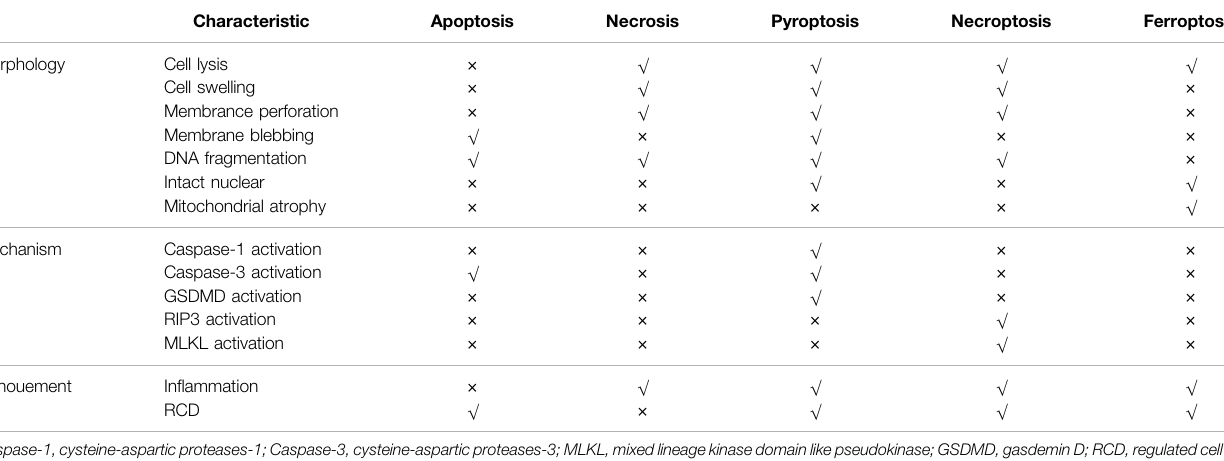
Frontiers in Cell and Developmental Biology |